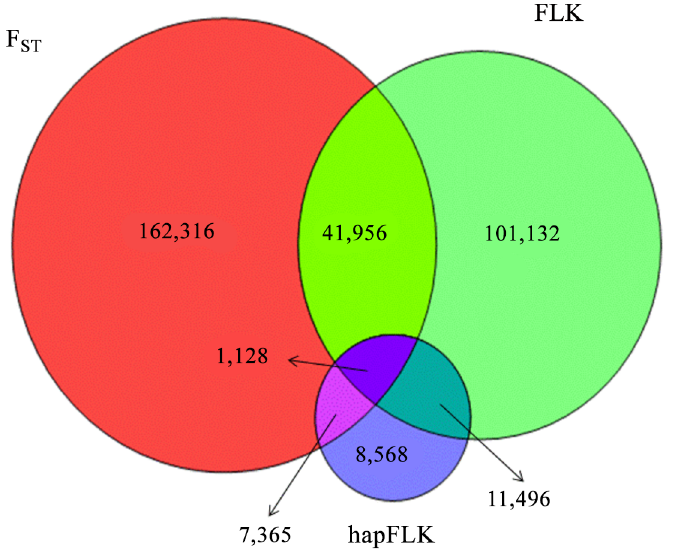
Fig 4. Venn diagram of overlapping SNPs identified as under selection, with F ST , FLK and hapFLK methods using same threshold (upper and lower 1%).